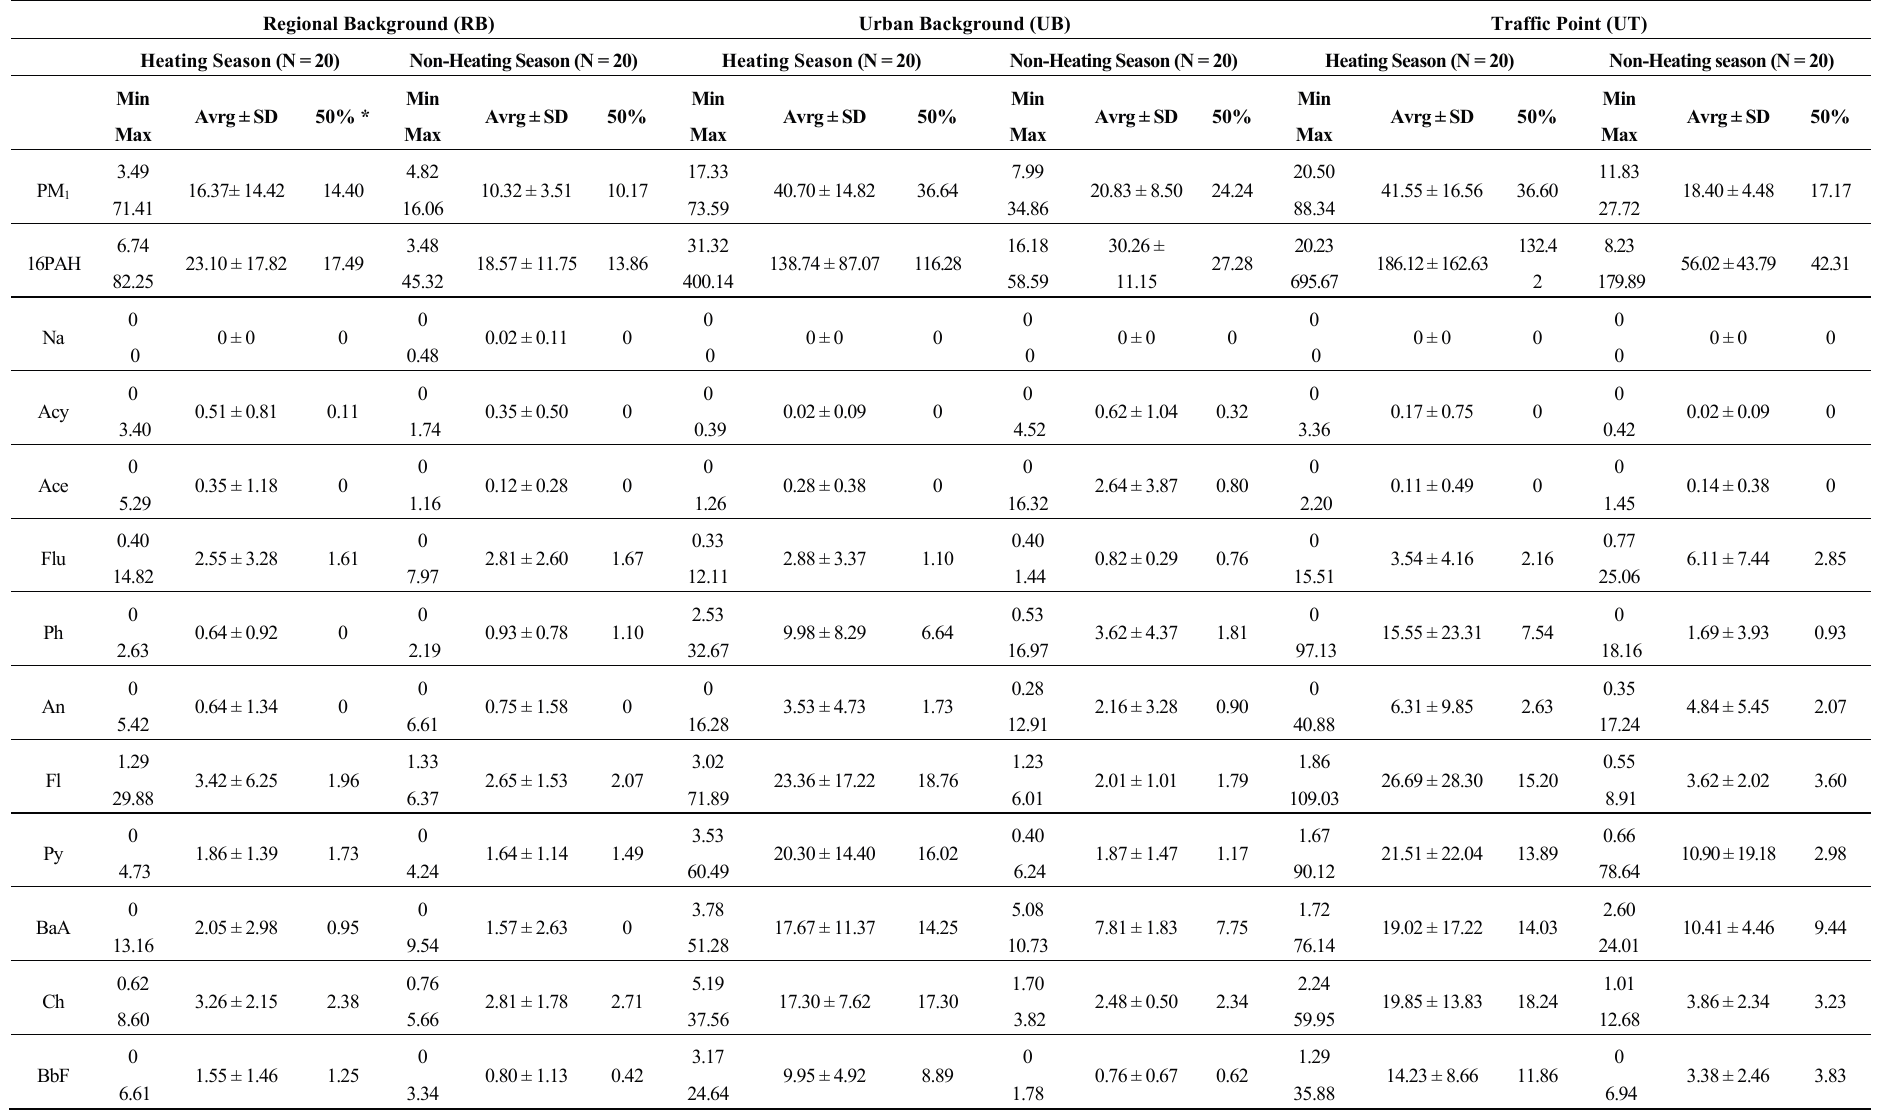
Table 1. The statistics of 24-h concentrations of PM 1 (µg·m − 3 ) and PM 1 -bound PAHs (ng·m − 3 ) at three locations in two measurement periods. Regional Background (RB) Urban Background (UB) Traffic Point (UT) Heating Season (N =